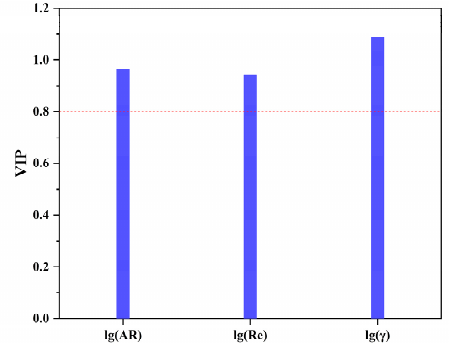
Figure 8. The plot of variable influence on projection with eccentricity factor 𝛾 .